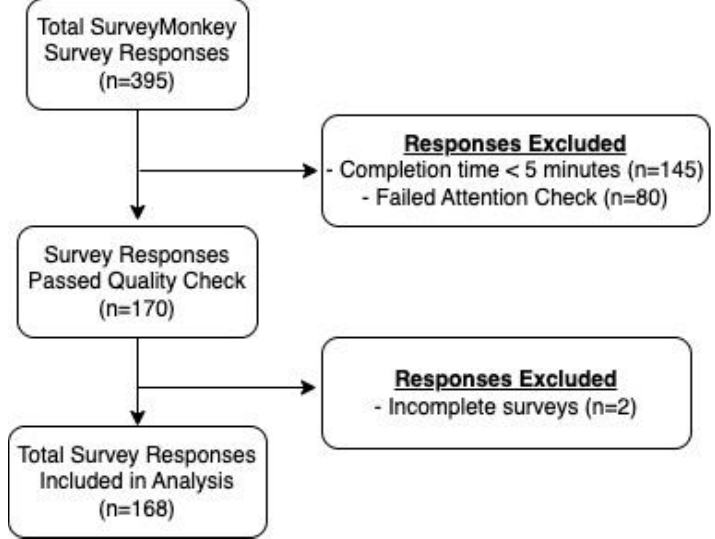
Figure 1. Participant responses flowchart.